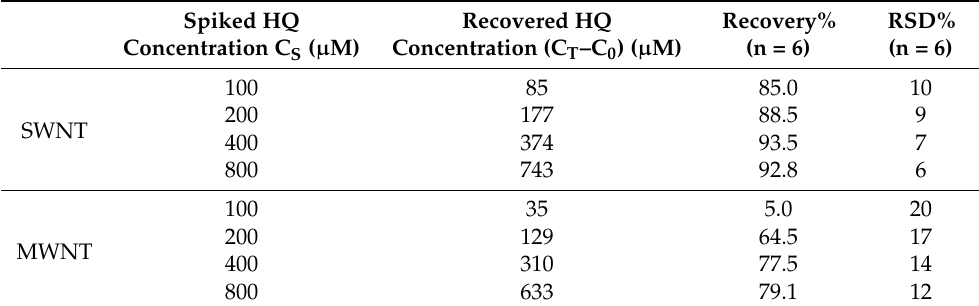
Table 4. Recovery study conducted on spiked-HQ water